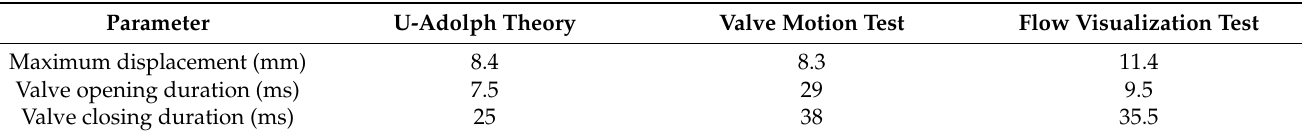
Table 2. Comparison between the U-Adolph predictions and the valve motion and flow visualization test results.